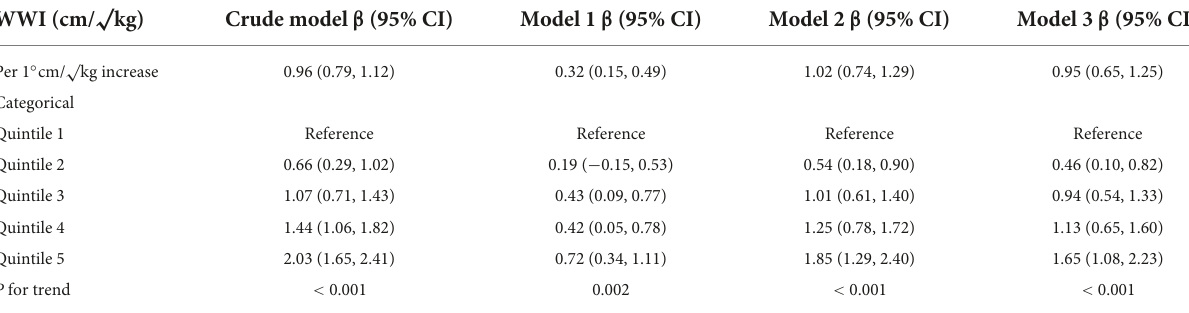
TABLE 2 Association between weight-adjusted-waist index (WWI) level and abdominal aortic calcification (AAC) score in United States adults from national health and nutrition examination survey (NHANES)